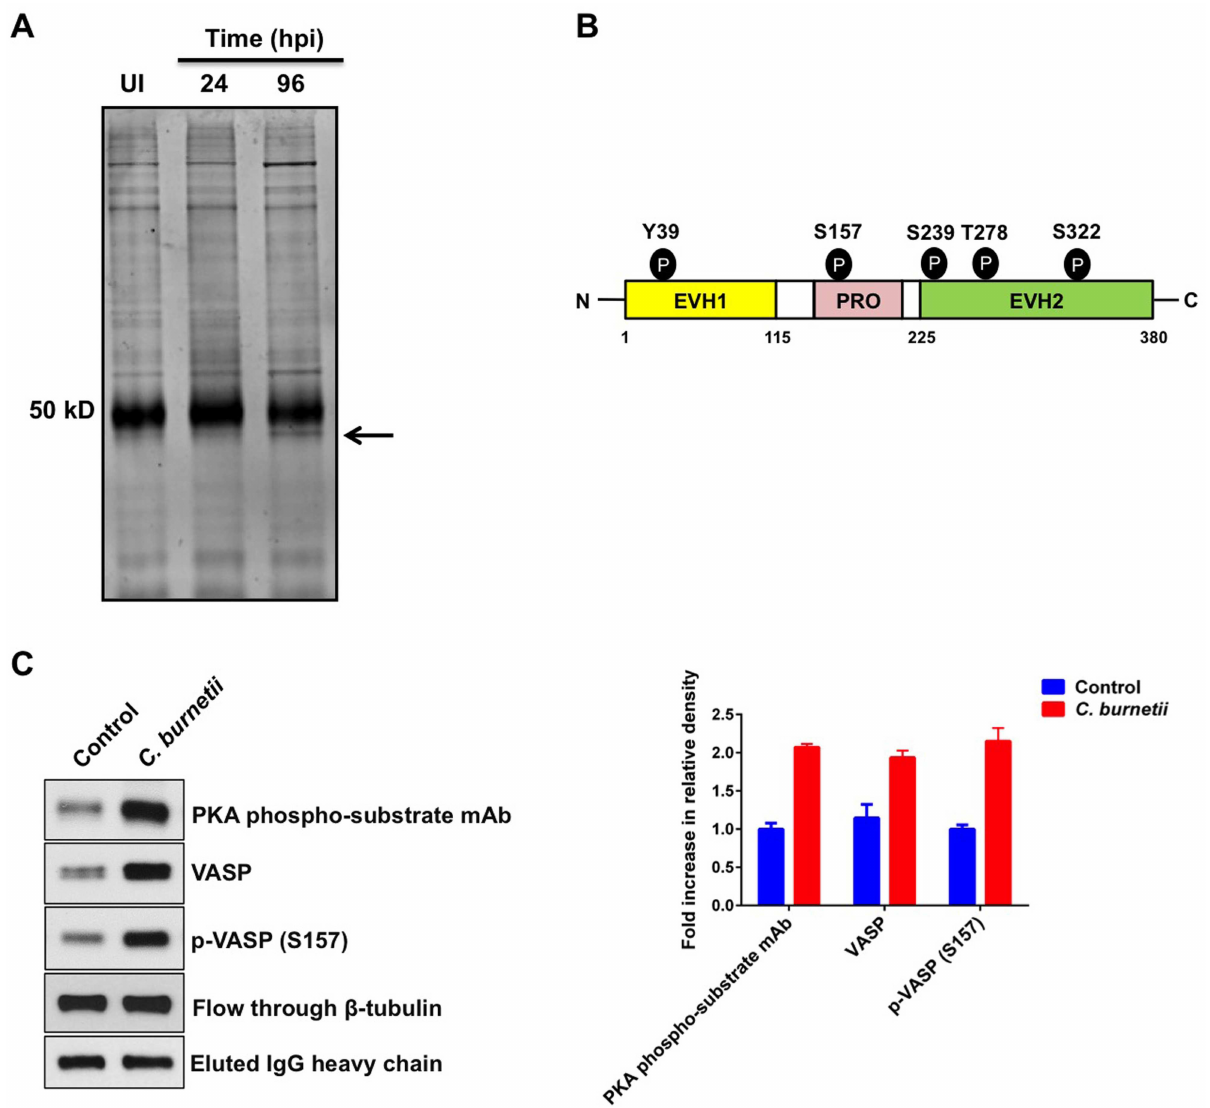
Fig 1. VASP is differentially phosphorylated during C . burnetii infection. THP-1 cells infected for 24 or 96 h and uninfected control cells were harvested and total protein immunoprecipitated with a PKA phospho substrate-specific antibody. (A) Immunoprecipitated proteins were subjectedto Coomassie Blue staining and the arrow indicates a ~ 47 kDa protein only in infected cell samples. UI = Uninfected Cells. (B) Schematic of VASP showingfive phosphorylation sites (Y39, S157, S239, T278, and S322) and EVH protein- protein interactiondomains. PRO = proline rich region. (C) Immunoprecipitatedproteins were subjectedto immunoblot analysisusing antibodiesdirected against VASP, phosphorylated VASP (S157), or PKA phosphosubstrates. Lysates were analyzedfor β -tubulin to confirm equal protein loading.Agarose bead-bound PKA phospho substrate-specific antibody was eluted, immunoblotted, and probed with anti-IgG antibody to confirm equal amounts of antibody for immunoprecipitations. Densitometry analysis is shown in the graph and represents an average of three independent experiments. Error bars indicate the standard error of the mean. Control = uninfectedcells. Increased levels of total and phosphorylated VASP (S157) are present in C . burnetii -infected cells.